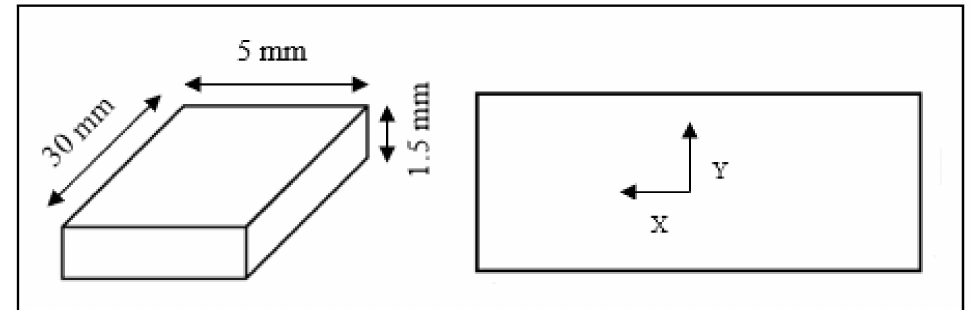
Figure 2. Workpiece model geometry.